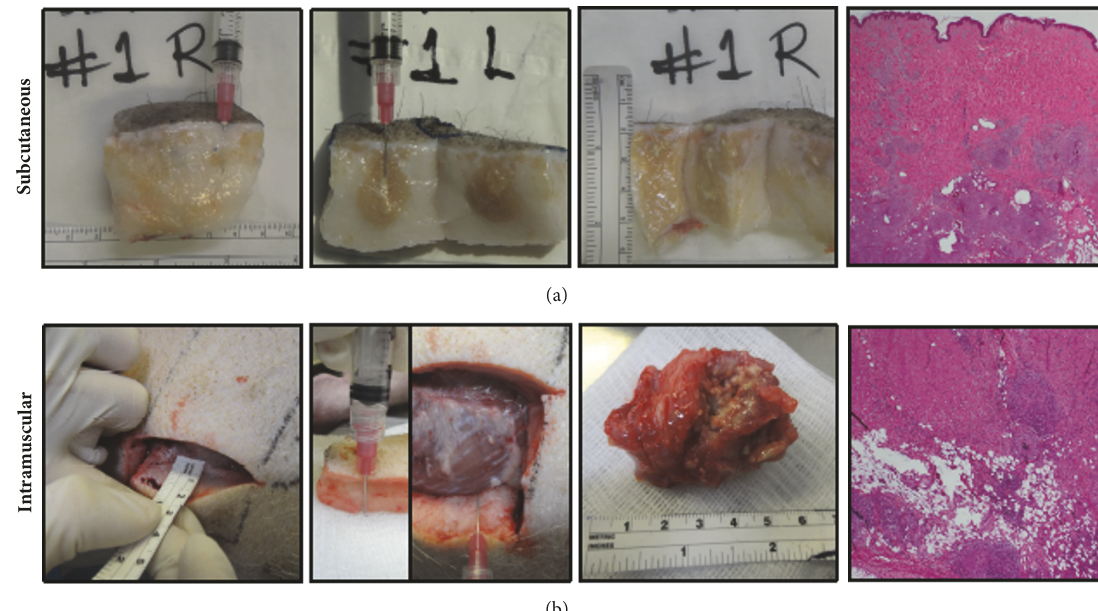
Figure 5: Macroscopic appearance and histologic analysis of the granulomas formed at autopsy, when CFA was injected SC (a) and (b) after intramuscular